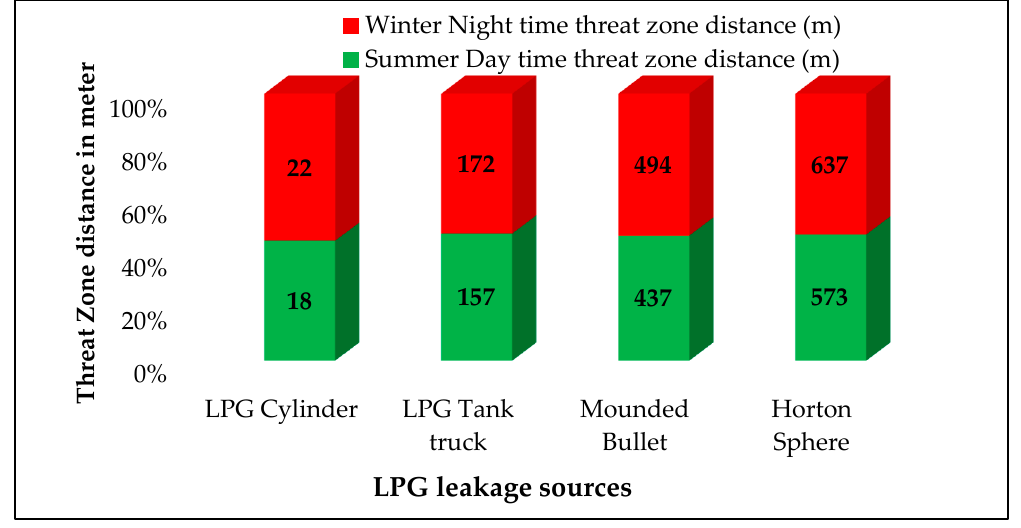
Figure 7. Fireball radiations of 37.5 kW/m 2 .